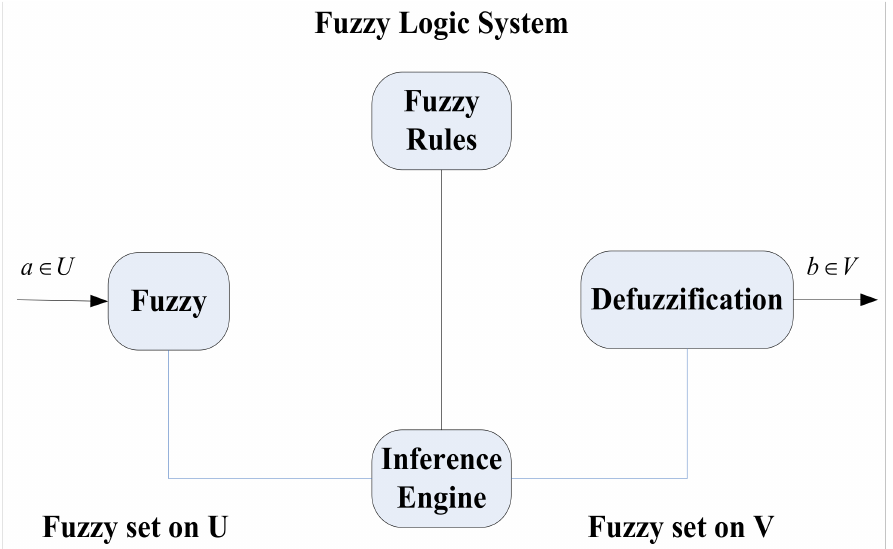
Figure 3. Basic fuzzy inference